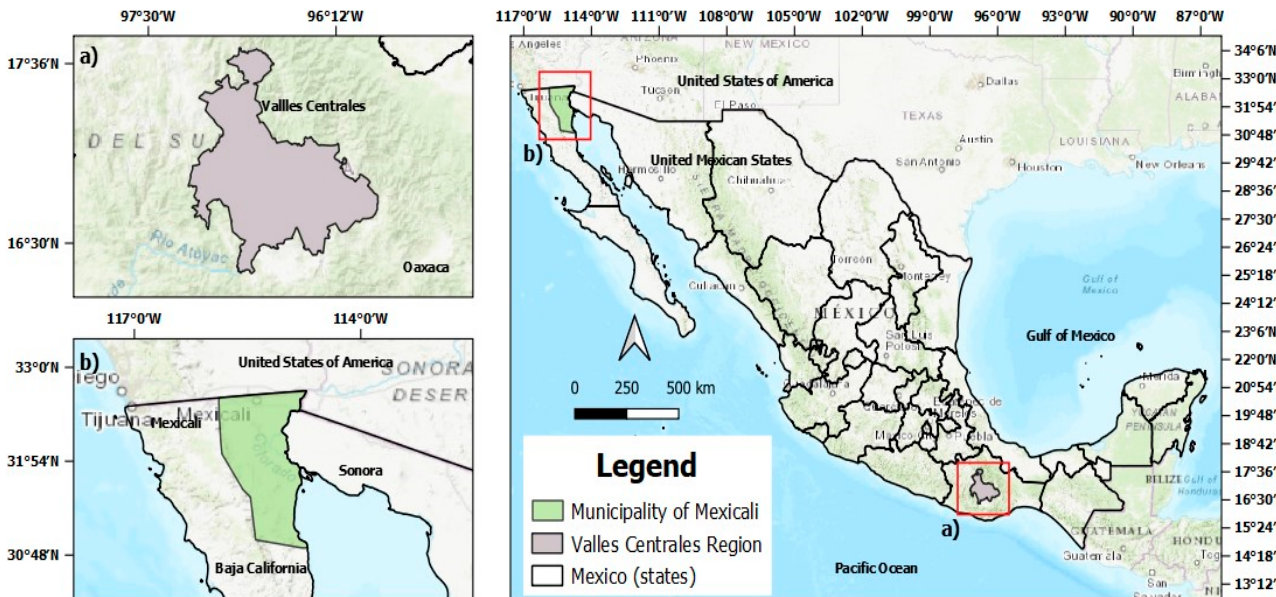
Figure 1. Location of the areas studied: ( a ) Valles Centrales region (Oaxaca); and ( b ) Municipality of Mexicali (Baja California). Source. Created with Qgis v3.14.16, with data from the Instituto Nacional de Estadística y Geografía (INEGI).